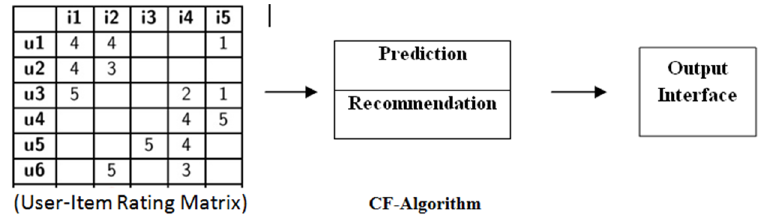
Figure 3. Collaborative Filtering Technique.